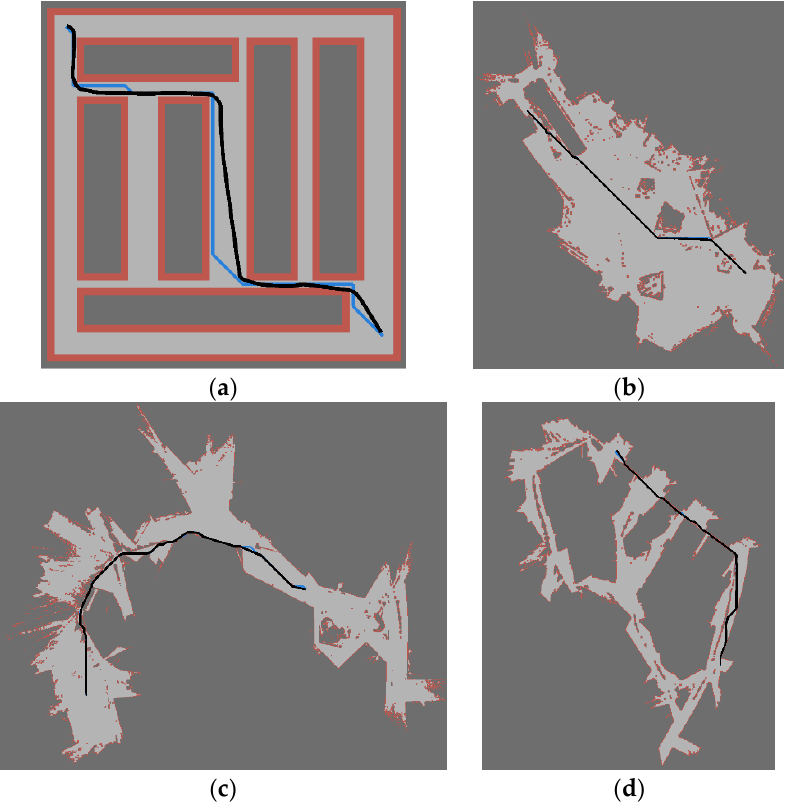
Figure 6. ( a ) Training environment—50 by 50. The training environment was a simplified office. ( b – d ) Given the start position and the goal position, the blue line is the path planned by the simple subgoal graph (SSG), and the black line is the trajectory planned by SG–RL. The dark-gray region is unpassable while the light-gray region is traversable for robots. Red regions deemed close to obstacles denote alert areas. ( b ) Building 1—820 by 820, ( c ) Building 2—1142 by 1142, ( d ) Building 3—792 by